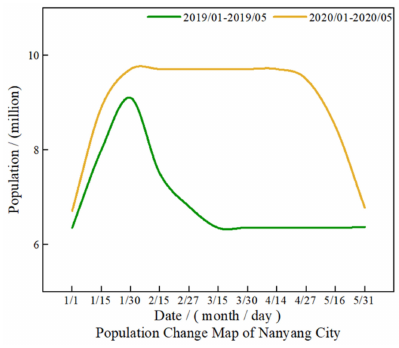
Figure 12. Urban population